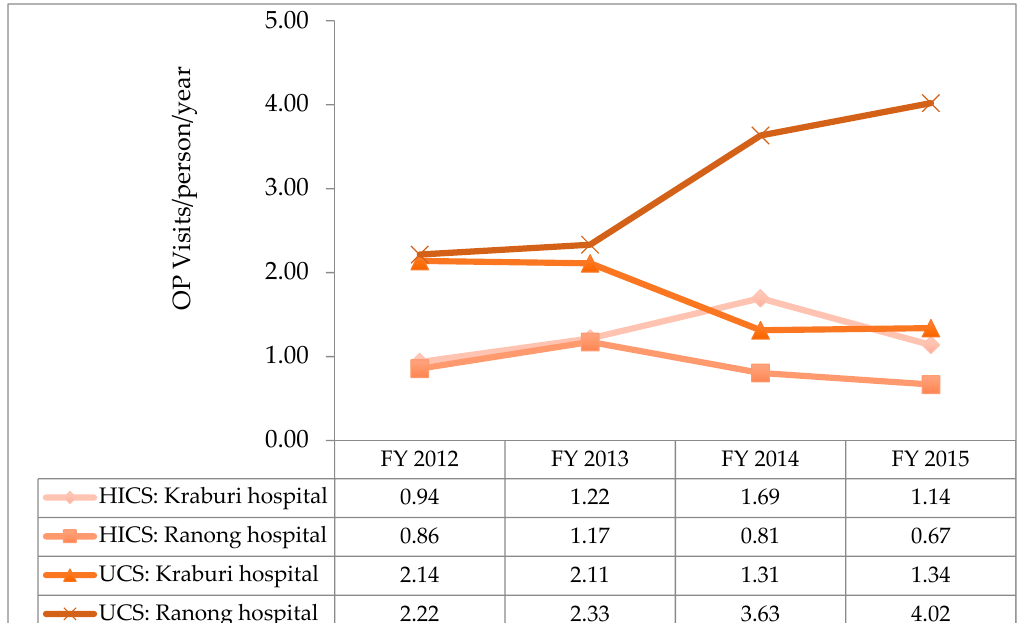
Figure 7. OP utilisation rate between the HICS and the UCS beneficiaries by years. Note: The utilisation rate at the health centre level cannot be analysed due to a lack of an accumulated number of registered migrants at subdistrict level.